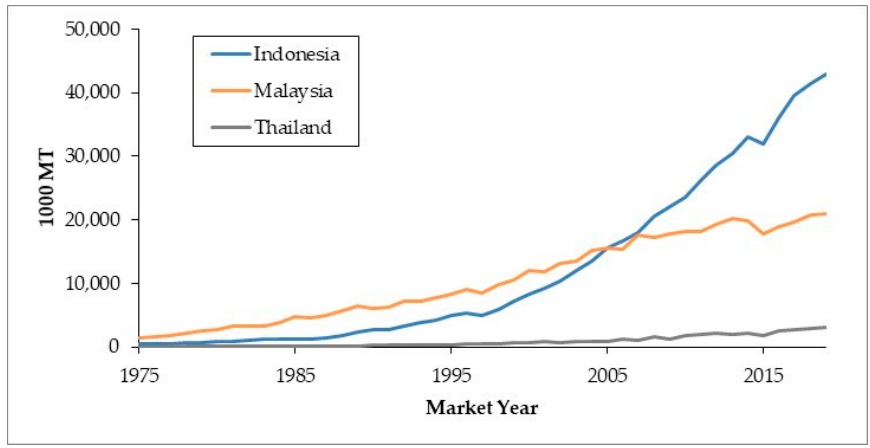
Figure 2. Comparison of palm oil production in Indonesia, Malaysia, and Thailand from 1975 to 2018. Adapted from ref. [7].